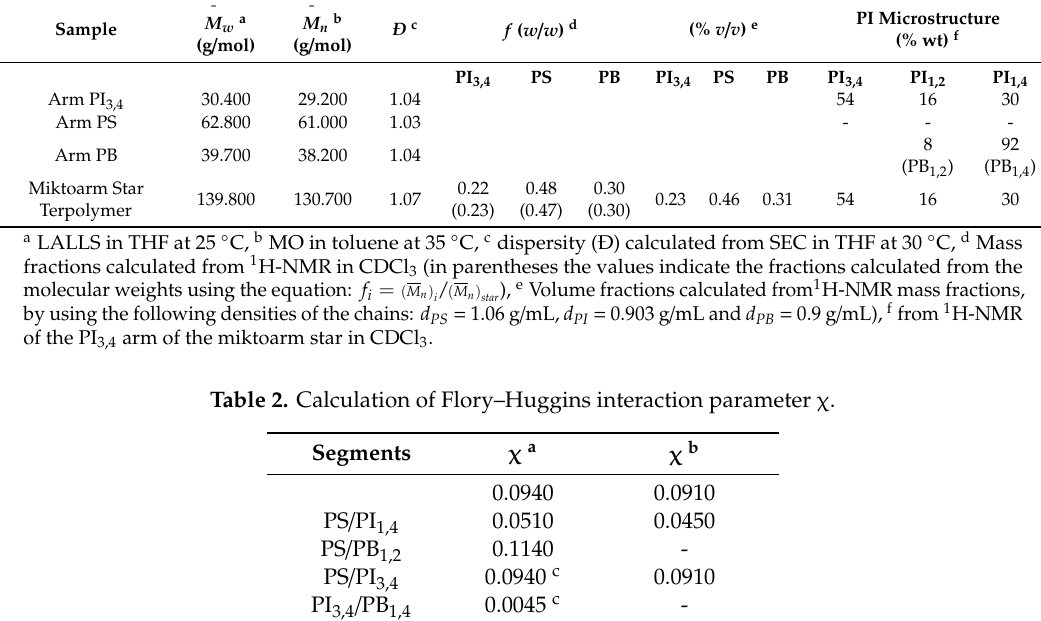
Table 1. Molecular characteristics of the precursors and the final 3-miktoarm star terpolymer. Sample